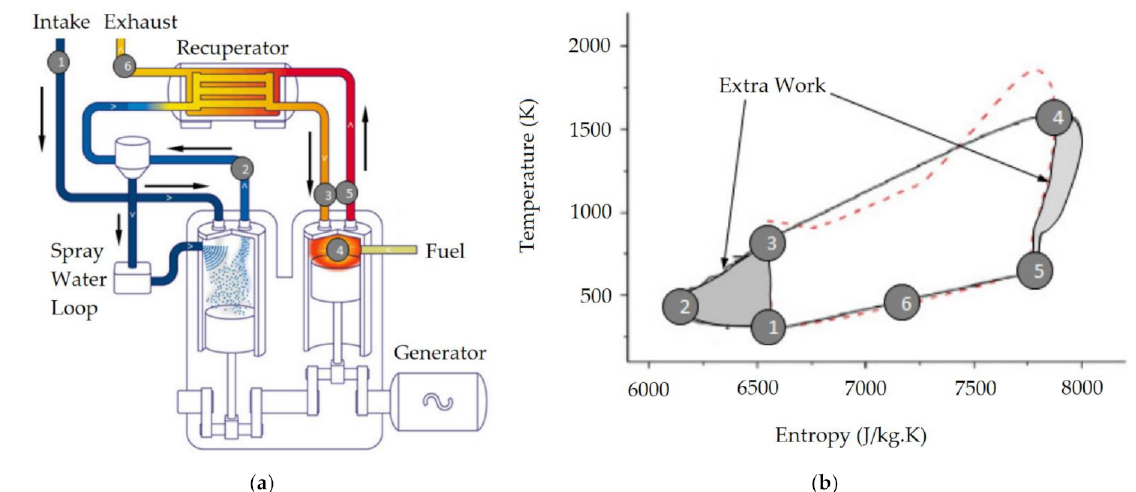
Figure 1. ( a ) Schematic diagram of RSCE concept; ( b ) Entropy diagram of RSCE (solid black line) compared to conventional Diesel (dashed red line), with extra areas of work highlighted in shaded grey areas. Numbers refer to positions in cycle in both diagrams ( a ) and ( b ) to aid comparison. Reprinted from Ref. [6] with permission. © SAE